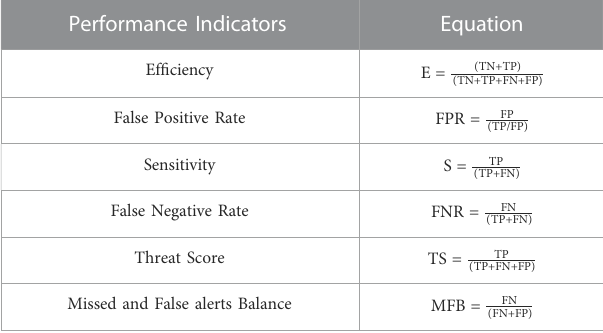
Table 3 all the used performance indicators are listed along with their equations, and in Figure 14 the graphs obtained for each test and con fi guration are shown. FIGURE 13